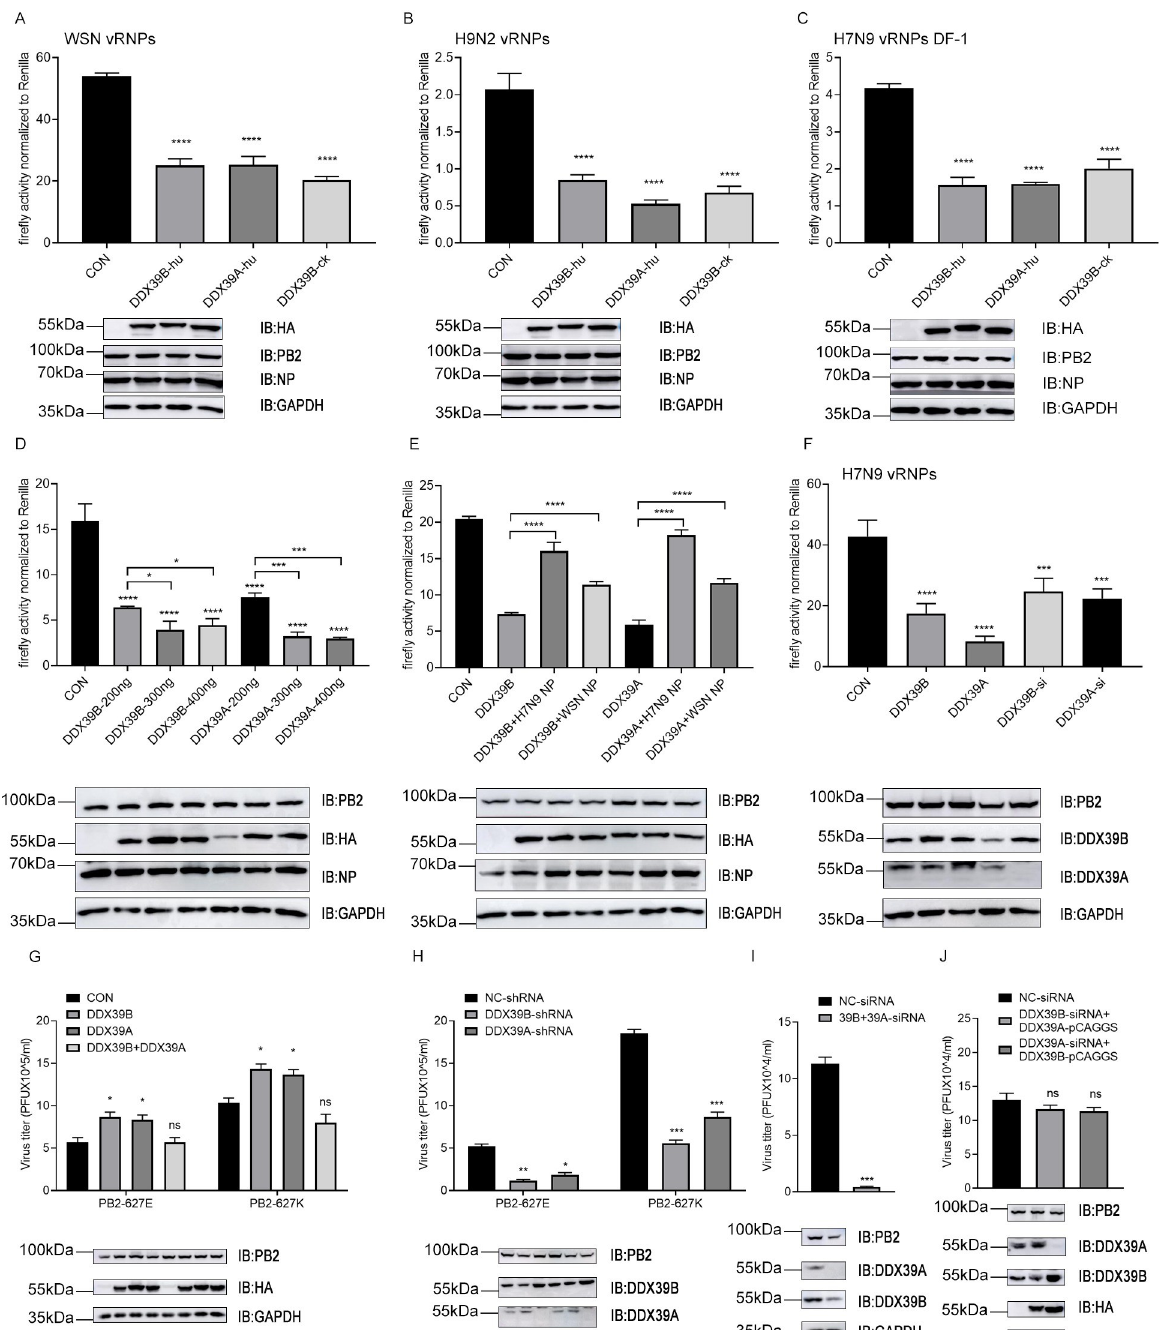
Fig 3. Effect of human and avian DDX39B or DDX39A on vRNP activity. (A, B and C) Polymerase genes (PB2 627 E) from either influenza virus H1N1 (A/WSN/1933) (A) or H9N2 (A/Chicken/Anhui/LH99/2017) (B), poll-Luc or pollck-Luc, RL-TK and corresponding plasmids encoding HA-DDX39B-hu, HA-DDX39A-hu, HA-DDX39B-ck or empty pCAGGS vectors were co-transfected into HEK293T cells (A and B) or DF-1 cells (C), 48h after transfection, the polymerase activity was detected. (D) Above polymerase genes (PB2 627 E), poll-Luc, RL-TK and gradually increased dose of HA-DDX39B or HA-DDX39A were co-transfected into HEK293T cells, 48h after transfection, the polymerase activity was detected. (E) Above polymerase genes (PB2 627 E), poll-Luc, RL-TK and gradually increased dose of NP of influenza virus H7N9 (A/Anhui/1/2013) or H1N1 (A/ WSN/1933), 48h after transfection, the polymerase activity was detected. (F) Detecting the effect of siRNA-mediated knockdown of DDX39B or DDX39A on polymerase activity. (G) HA-DDX39B, HA-DDX39A or empty pCAGGS vectors were transfected into HEK293T cells, 24 hours after transfection, cells were infected with the recombinant influenza viruses WSN-H7 (627K) or WSN-H7 (627E) at MOI = 0.05. The supernatants